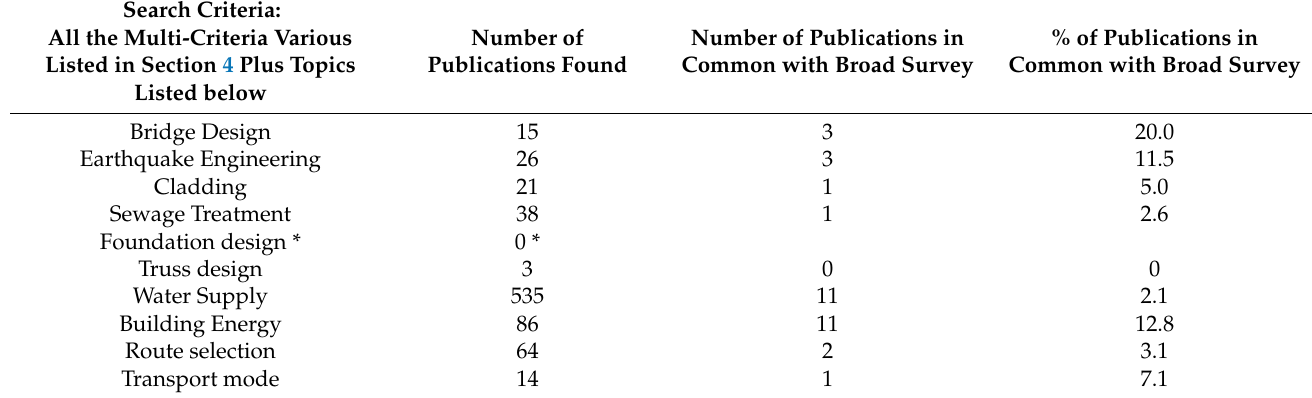
Table 5. Effect of narrowing focus from discipline to